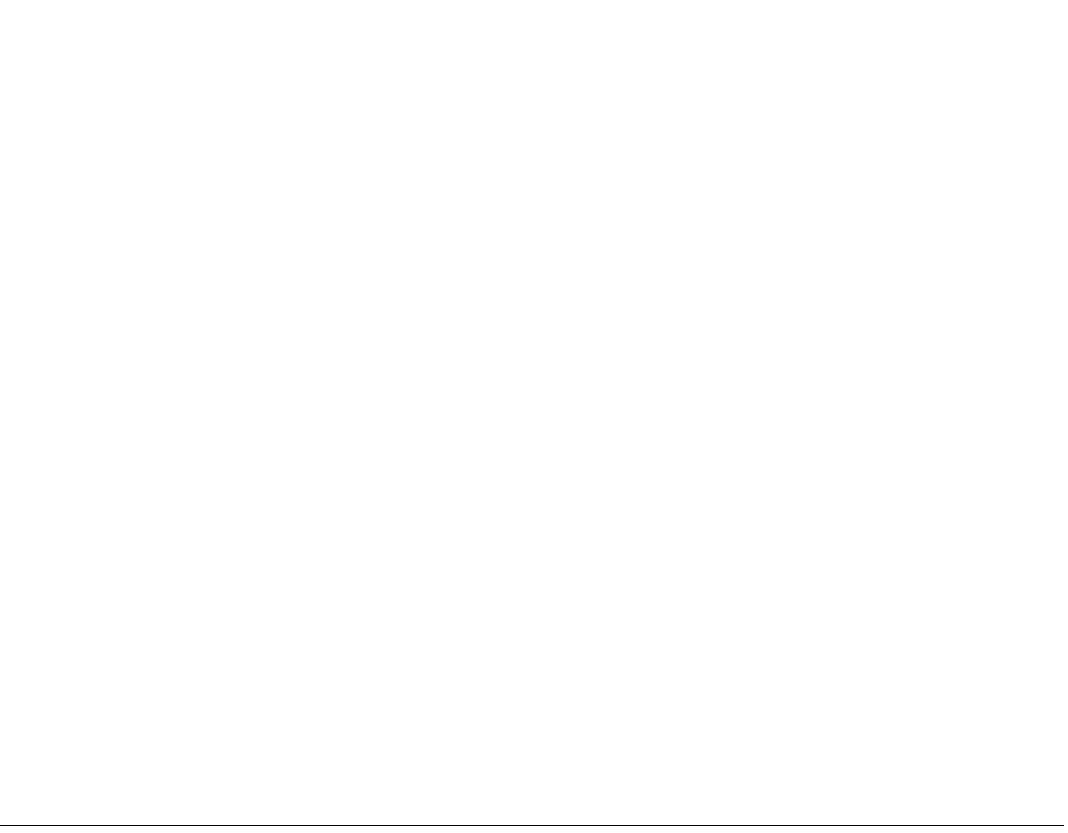
Figure 13. PD and PID Controller under different parameters, Switch time = 180